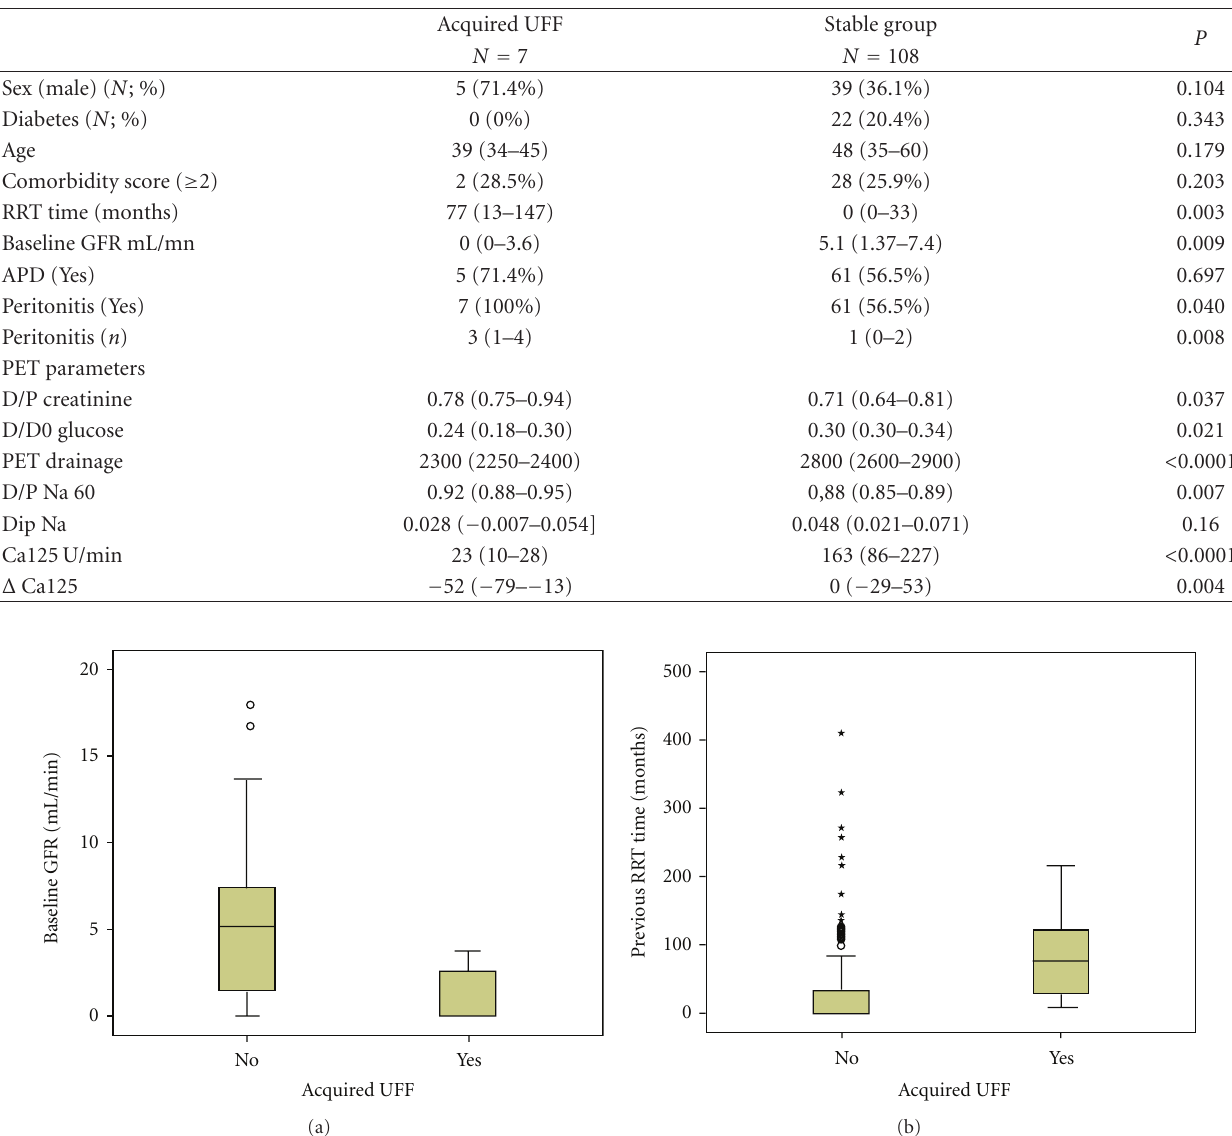
Table 2: Comparison between acquired UFF group and stable patients (categorical data as number (percentage) compared by Fisher’s exact test; continuous data presented as median (25%–75% interquartile range), compared by Mann Whitney U -test); Δ Ca125 is the variation between last evaluation in the followup and baseline e ffl uent CA125U/min levels.